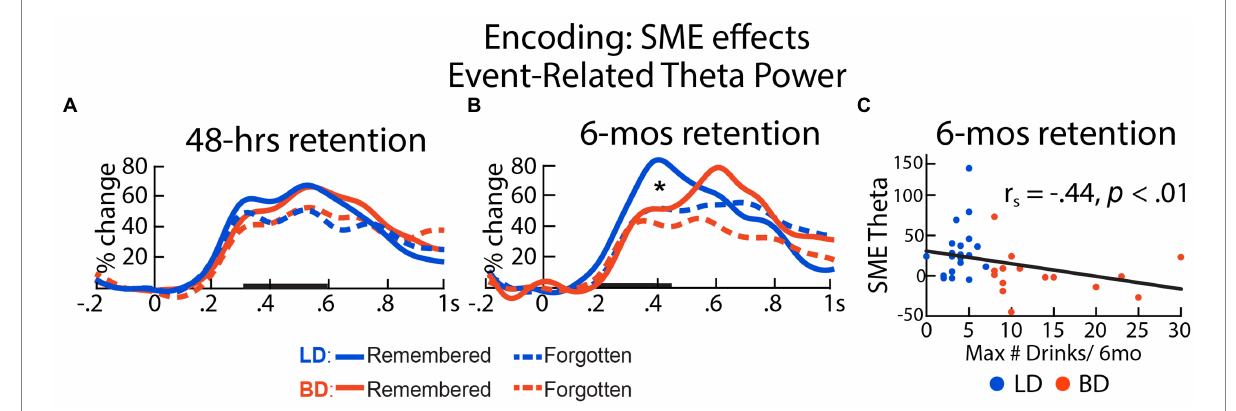
FIGURE 3 Event-related theta power during initial encoding associated with later remembered vs. forgotten pictures for LD and BD groups as a function of recognition (A) after 48 h and (B) after 6 mos. Event-related theta power is expressed as percent signal change from the baseline. (C) SME-related theta power difference (remembered – forgotten after 6 mos) correlated negatively with self-reported maximum number of drinks consumed on a single occasion in the past 6 months. * p ≤ 0.05. Bolded bars on the x -axis mark the time windows of